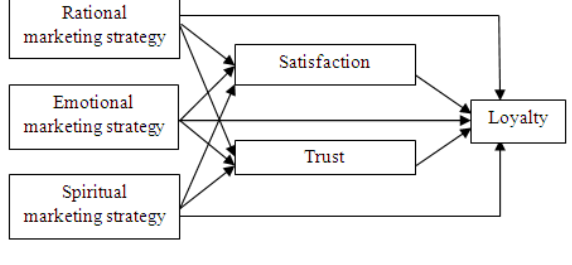
Fig. 1. Conceptual